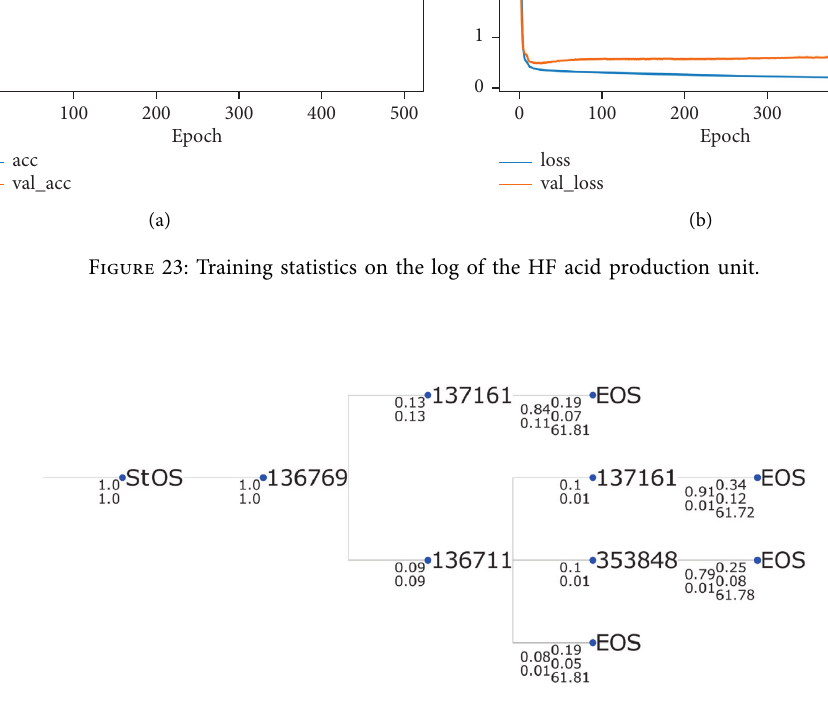
Figure 24: Output of the seq2probTree method for the HF production unit with input [136769].